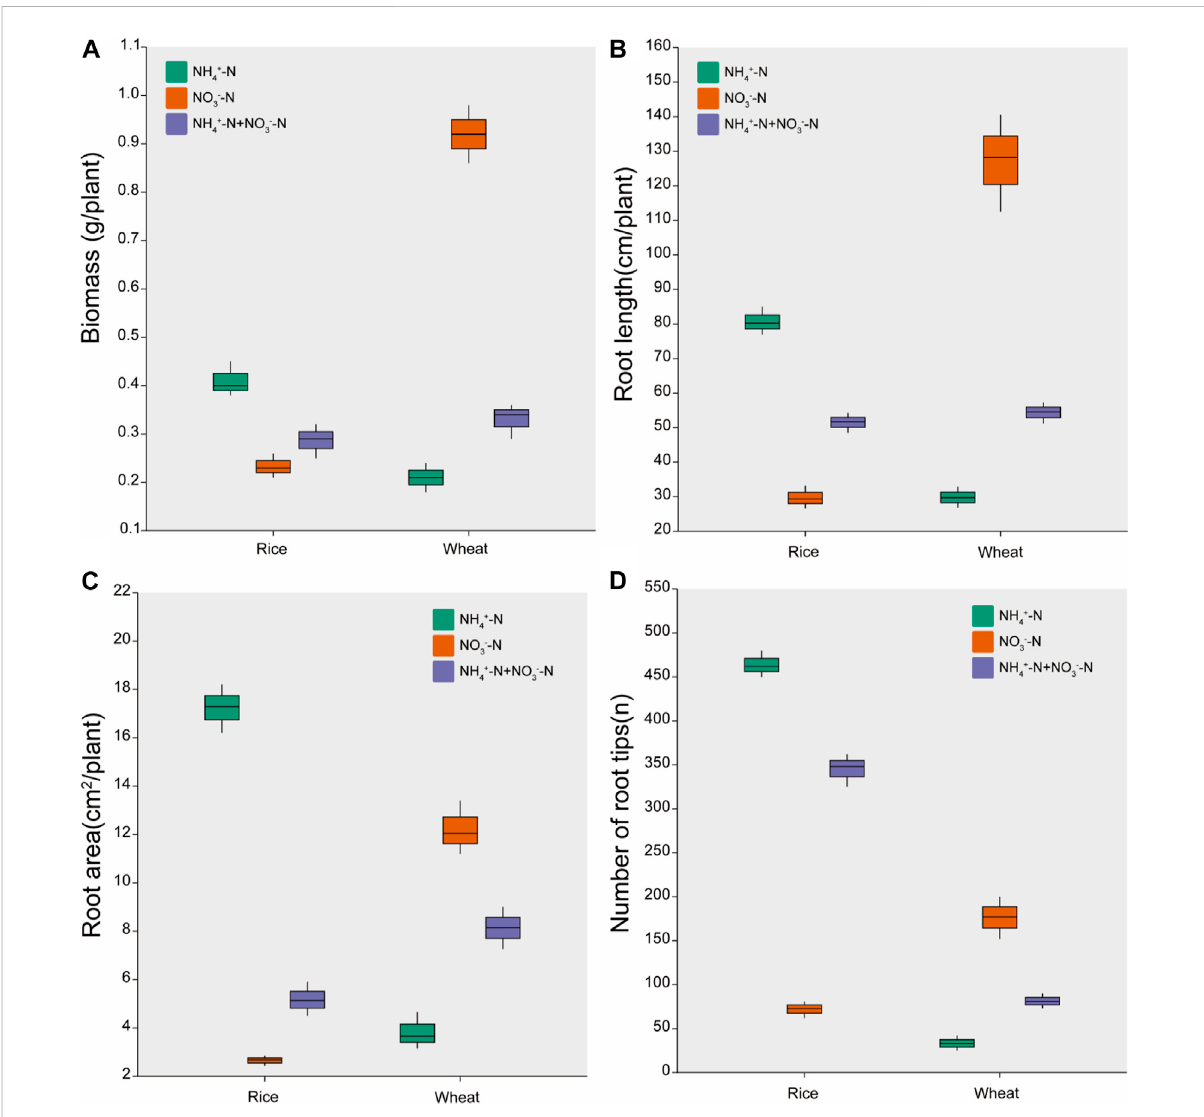
FIGURE 1 Effects of different nitrogen forms on the growth responses. Data are presented for (A) Plant biomass, (B) Root length, (C) Root area, and (D) number of root tips. Data are means ± standard error of four replicates ( n =